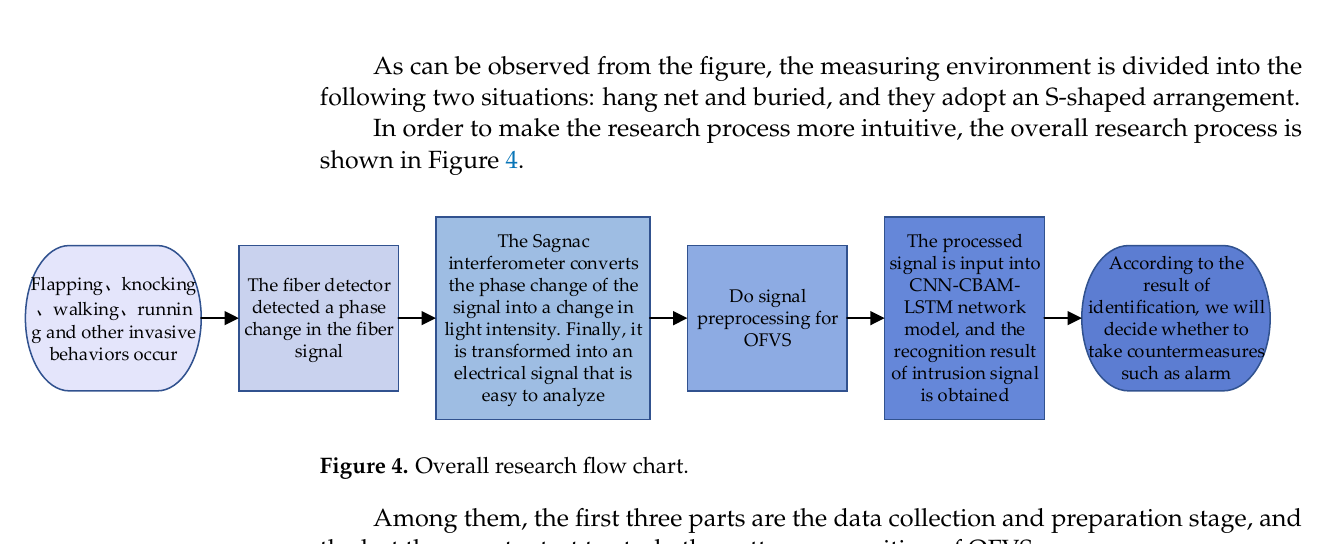
Figure 5. Signal preprocessing flow chart.